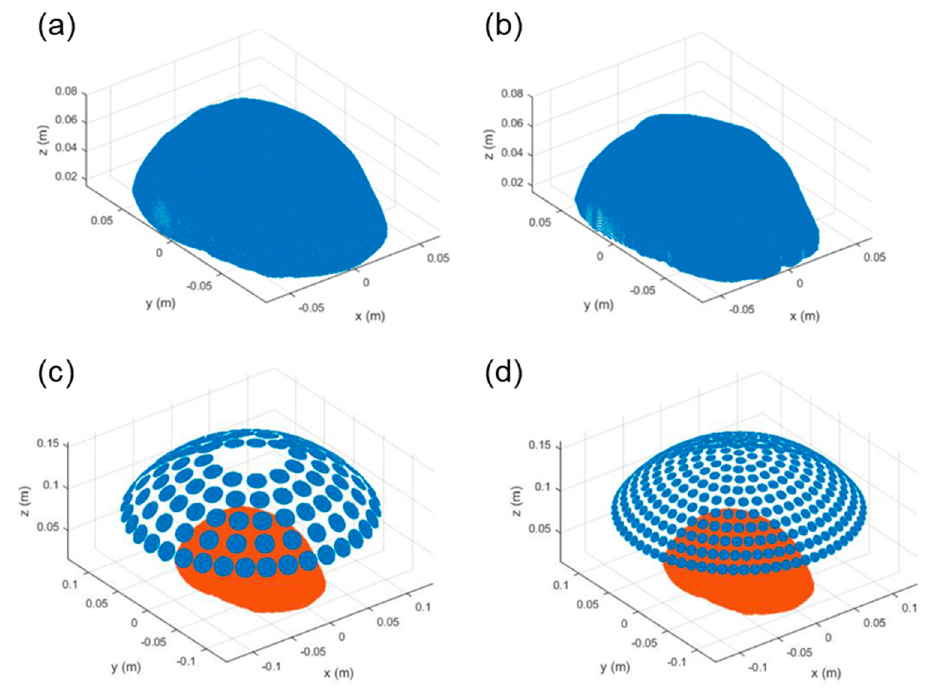
Figure 1. Numerical modeling of the human skull and the focused ultrasound transducers. The outer layer and inner layer of the skull were the interfaces between water and the skull bone ( a ) and between the bone and the brain ( b ), respectively. ( c , d ) show the models of 114-element and 381-element transducers above the